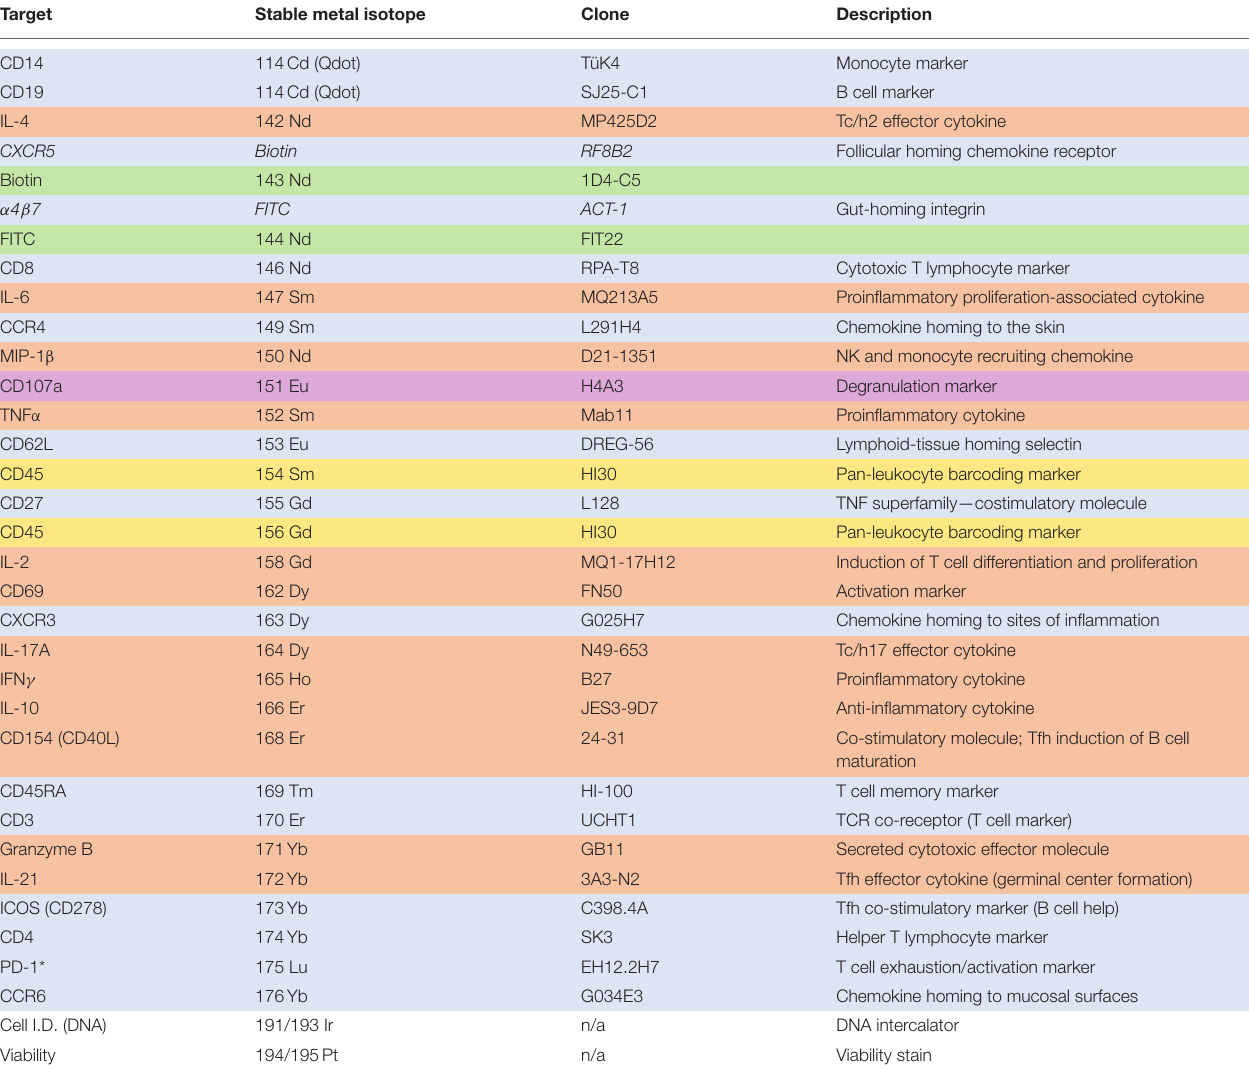
TABLE 2 | Mass cytometry panel showing antibody target, stable metal isotope (or other label), antibody clone, and a brief description of the target